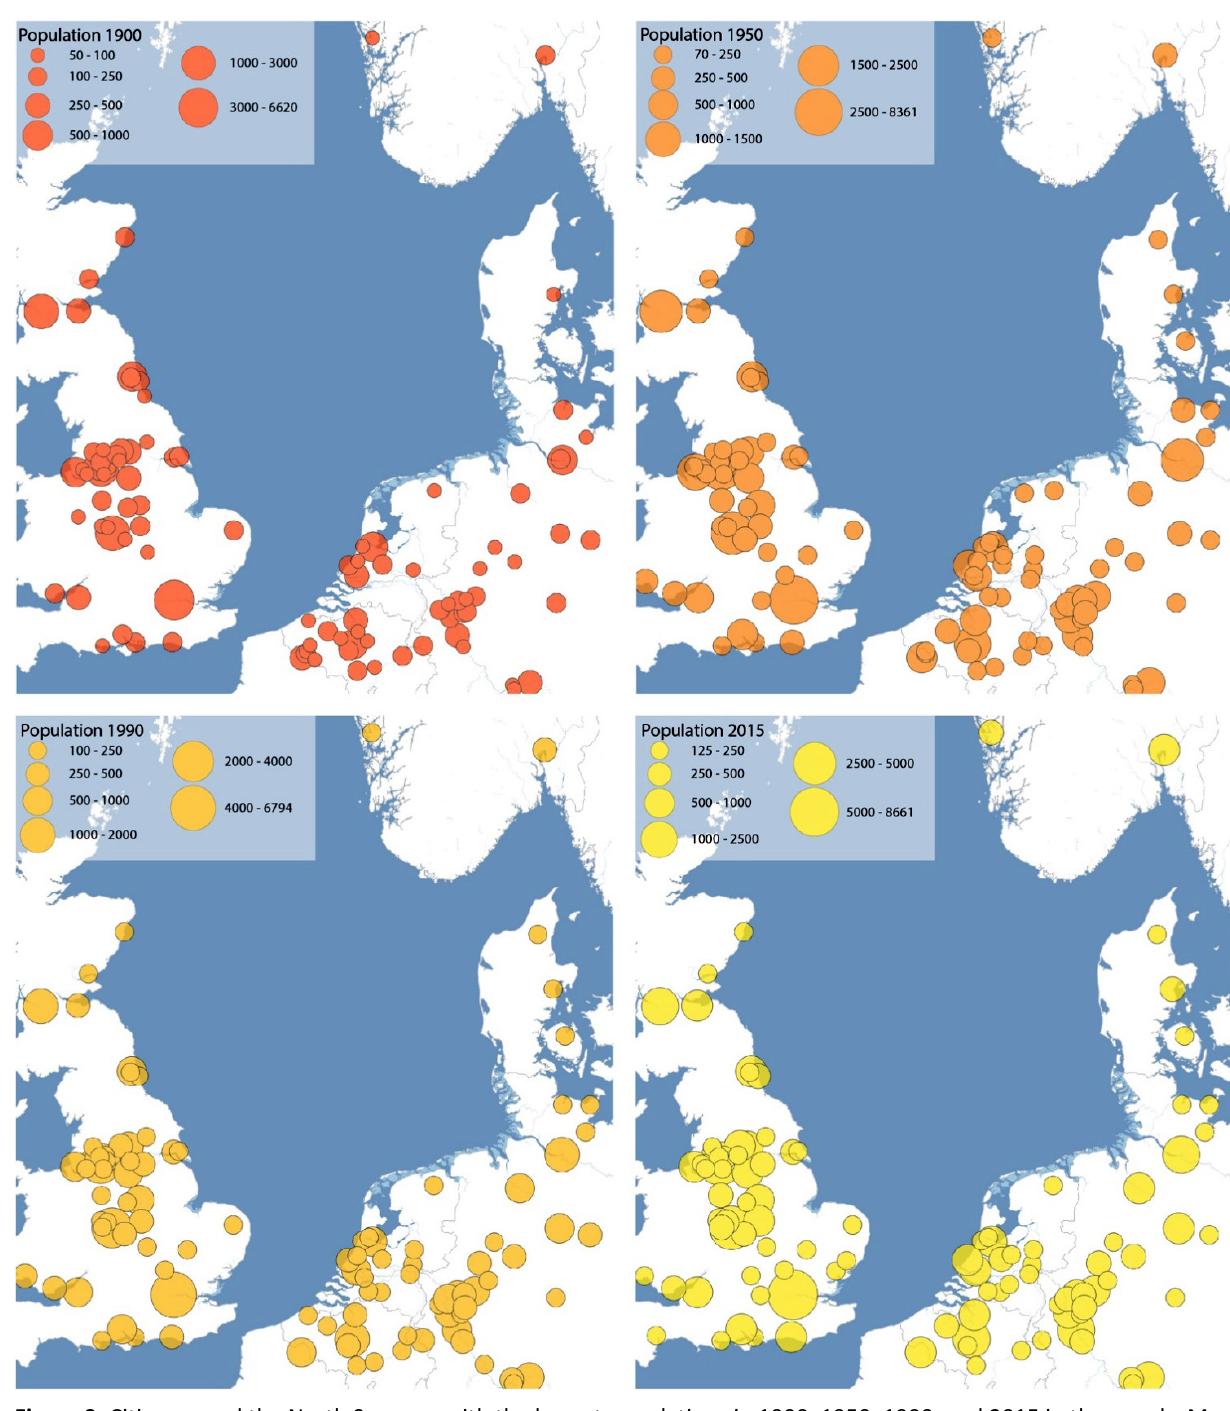
Figure 9. Cities around the North Sea area with the largest populations in 1900, 1950, 1990, and 2015 in thousands. Map by Yvonne van Mil. Source: van Mil and Rutte (2020a,